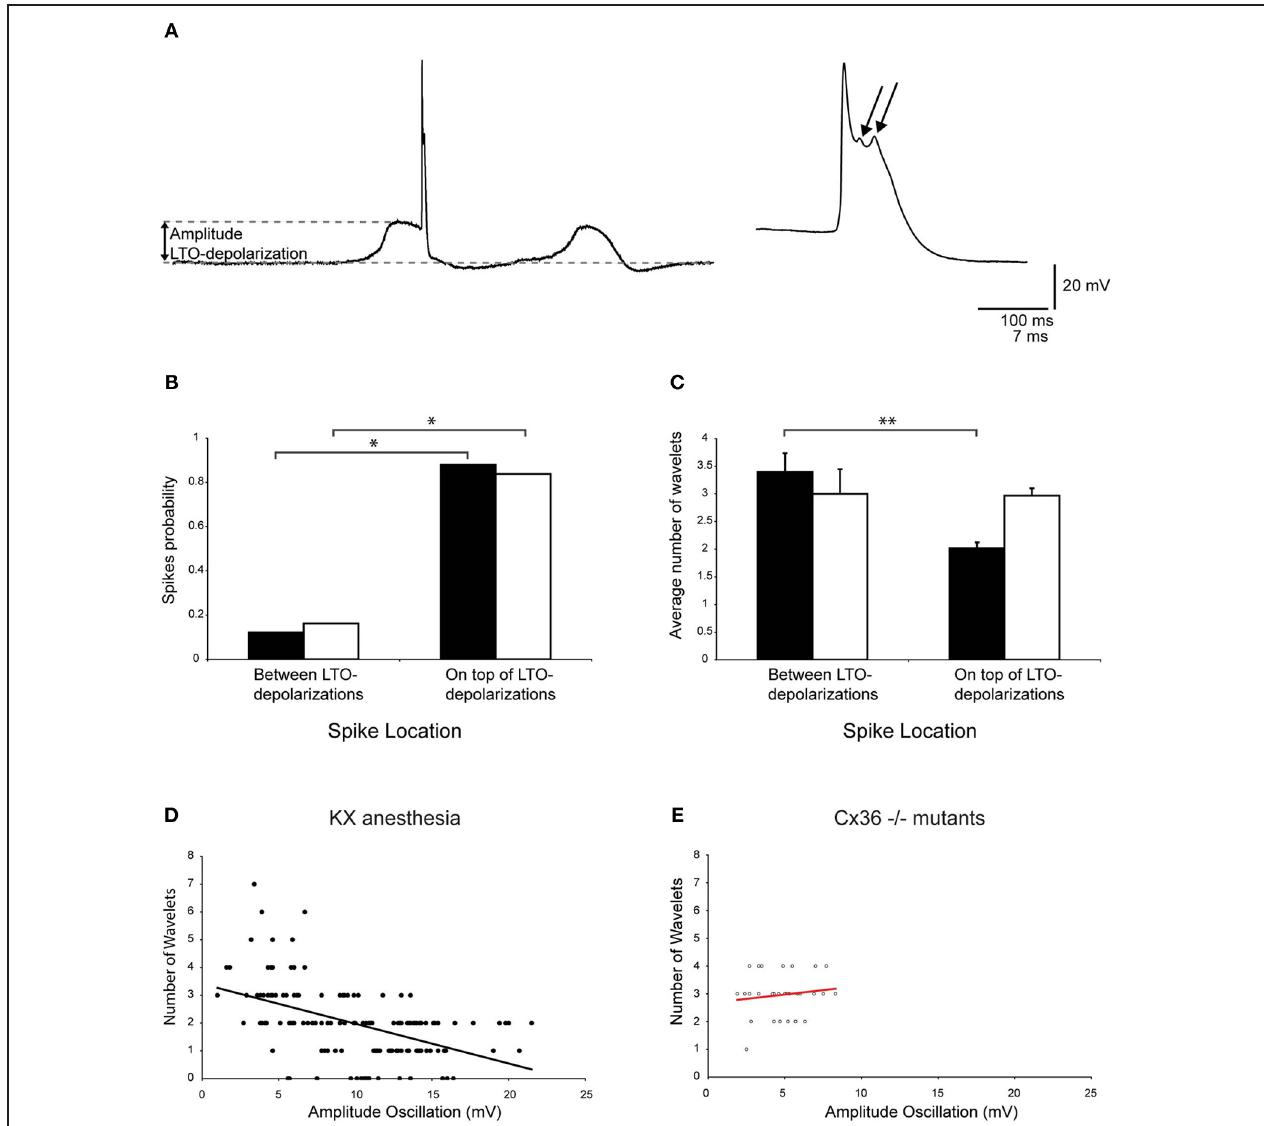
FIGURE 8 | Modulation of olivary wavelets by low-threshold Ca 2 + depolarizations. (A) Left panel: trace of a spontaneous low-threshold Ca 2 + depolarizations from an in vivo olivary neuron. The gray dashed lines indicate the amplitude of the low-threshold Ca 2 + depolarization. Right panel: enlargement of the olivary action potential shown in the left panel. The arrows indicate the olivary wavelets on top of the afterdepolarization. (B) The occurrence of spikes (spike probability) in relation to spike position relative to the low-threshold Ca 2 + oscillations obtained from recordings measured from either wild type (black bars, n = 165) or Cx36 − / − mutant mice (open bars, n = 37). * p < 0 . 05 ( χ 2 -test).